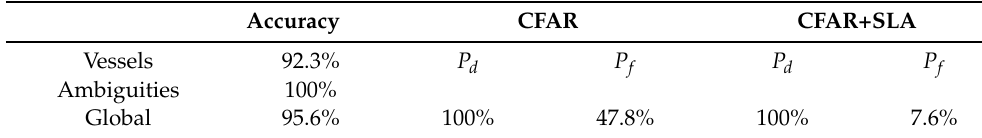
Table 6. Accuracy of the CFAR+SLA algorithm and performance in terms of probability of detection and false alarm rate pre- and post-application of the discrimination